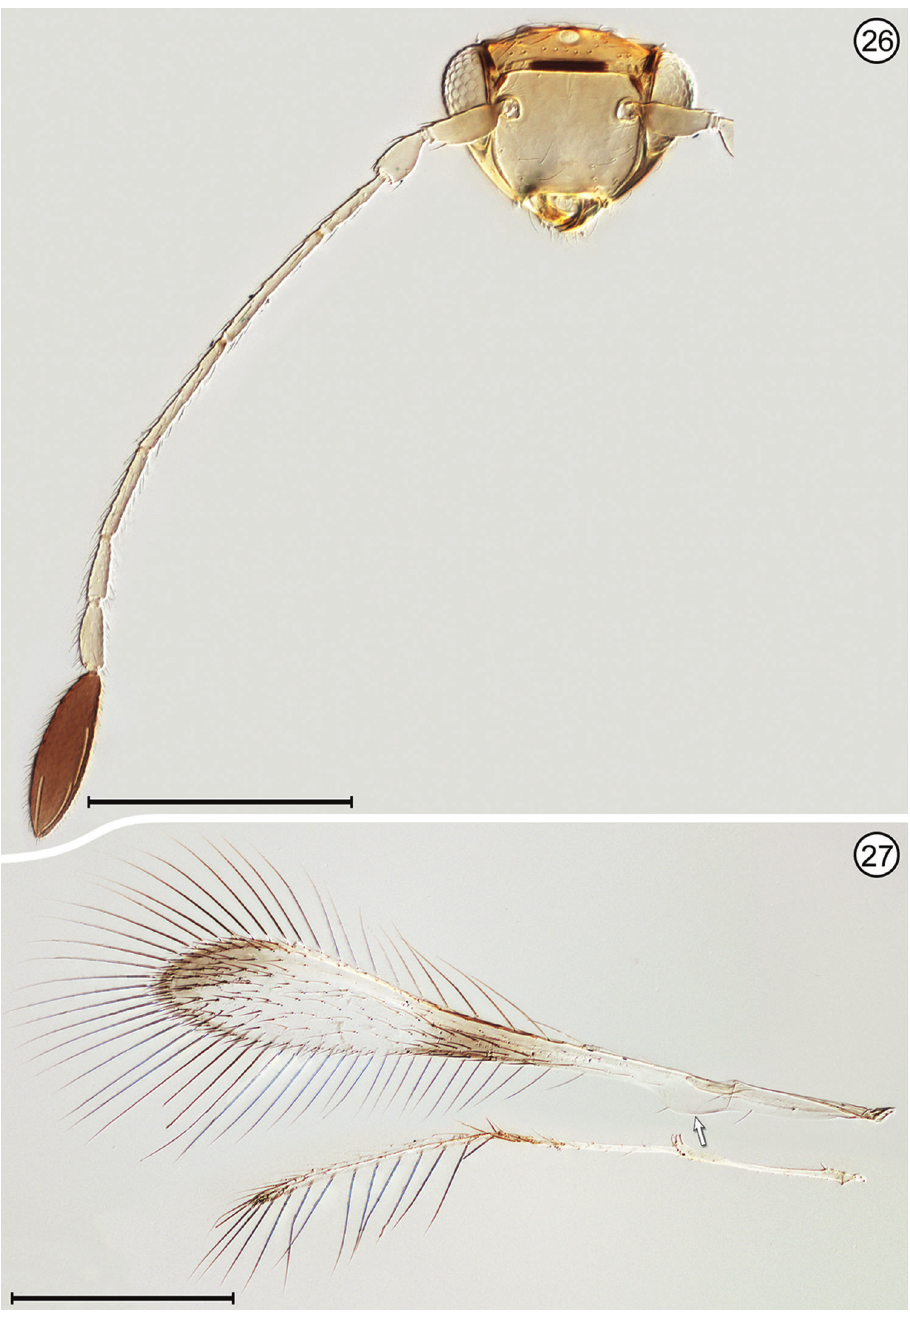
Figures 26, 27. Palaeoneura bagicha , female 26 head, anterior + antenna 27 wings. Scale bars = 200